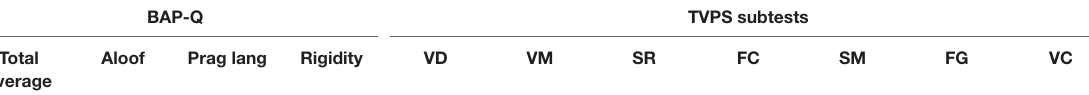
TABLE 4 | Partial correlation (FSIQ) between BAP-Q and TVPS scores with correction for multiple comparisons.